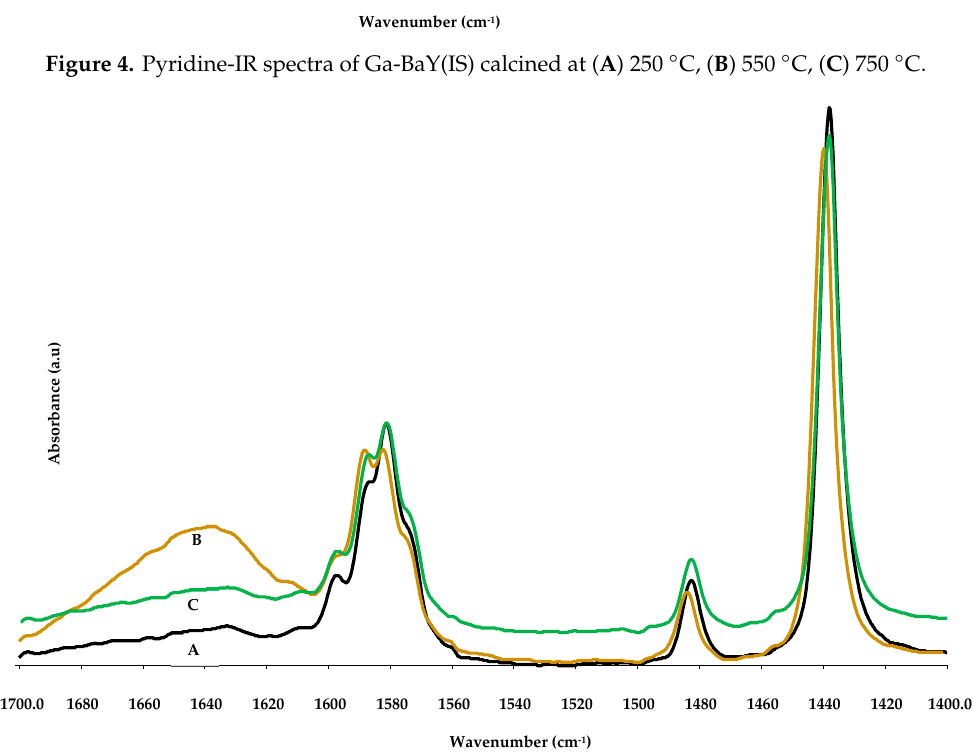
◦ C, ( B ) 550 ◦ C, ( C ) 750 ◦